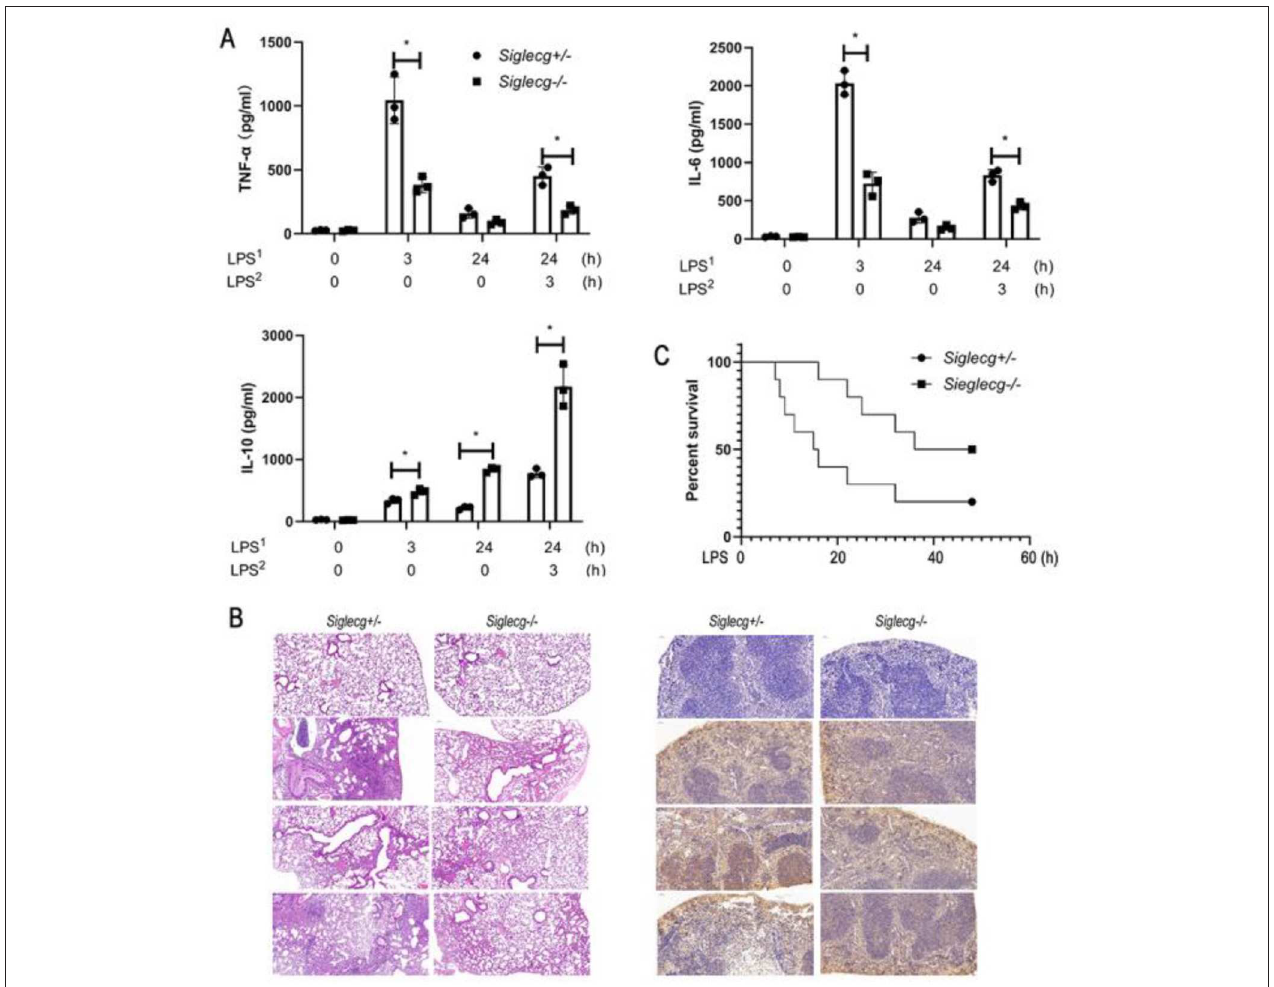
FIGURE 1 | Siglecg -deficient mice are more resistant to LPS-induced sepsis. (A) Enzyme-linked immunosorbent assay (ELISA) of TNF- α , IL-6, and IL-10 in serum from Siglecg + / − and Siglecg − / − mice injected intraperitoneally with PBS or LPS (5 mg/kg) as indicated. Data are representative of three independent experiments with similar results and presented as means ± SD. * P < 0.01. (B) Hematoxylin and eosin staining of the lungs (left panel); the immunostaining of phosphor-p65 (middle panel) in the spleen from Siglecg + / − and Siglec − / − mice after intraperitoneal injection of PBS or LPS as indicated. Original magnification: × 10 for the lungs and × 20 for the spleen. Data are representative of three independent experiments with similar results. (C) Survival of Siglecg + / − and Siglecg − / − mice ( n = 10 per genotype), monitored every hour after challenge with lethal dose of LPS (15 mg/kg). P < 0.01 (Wilcoxon test). LPS, lipopolysaccharide; IL, interleukin; TNF- α , tumor necrosis factor- α ; PBS, phosphate-buffered